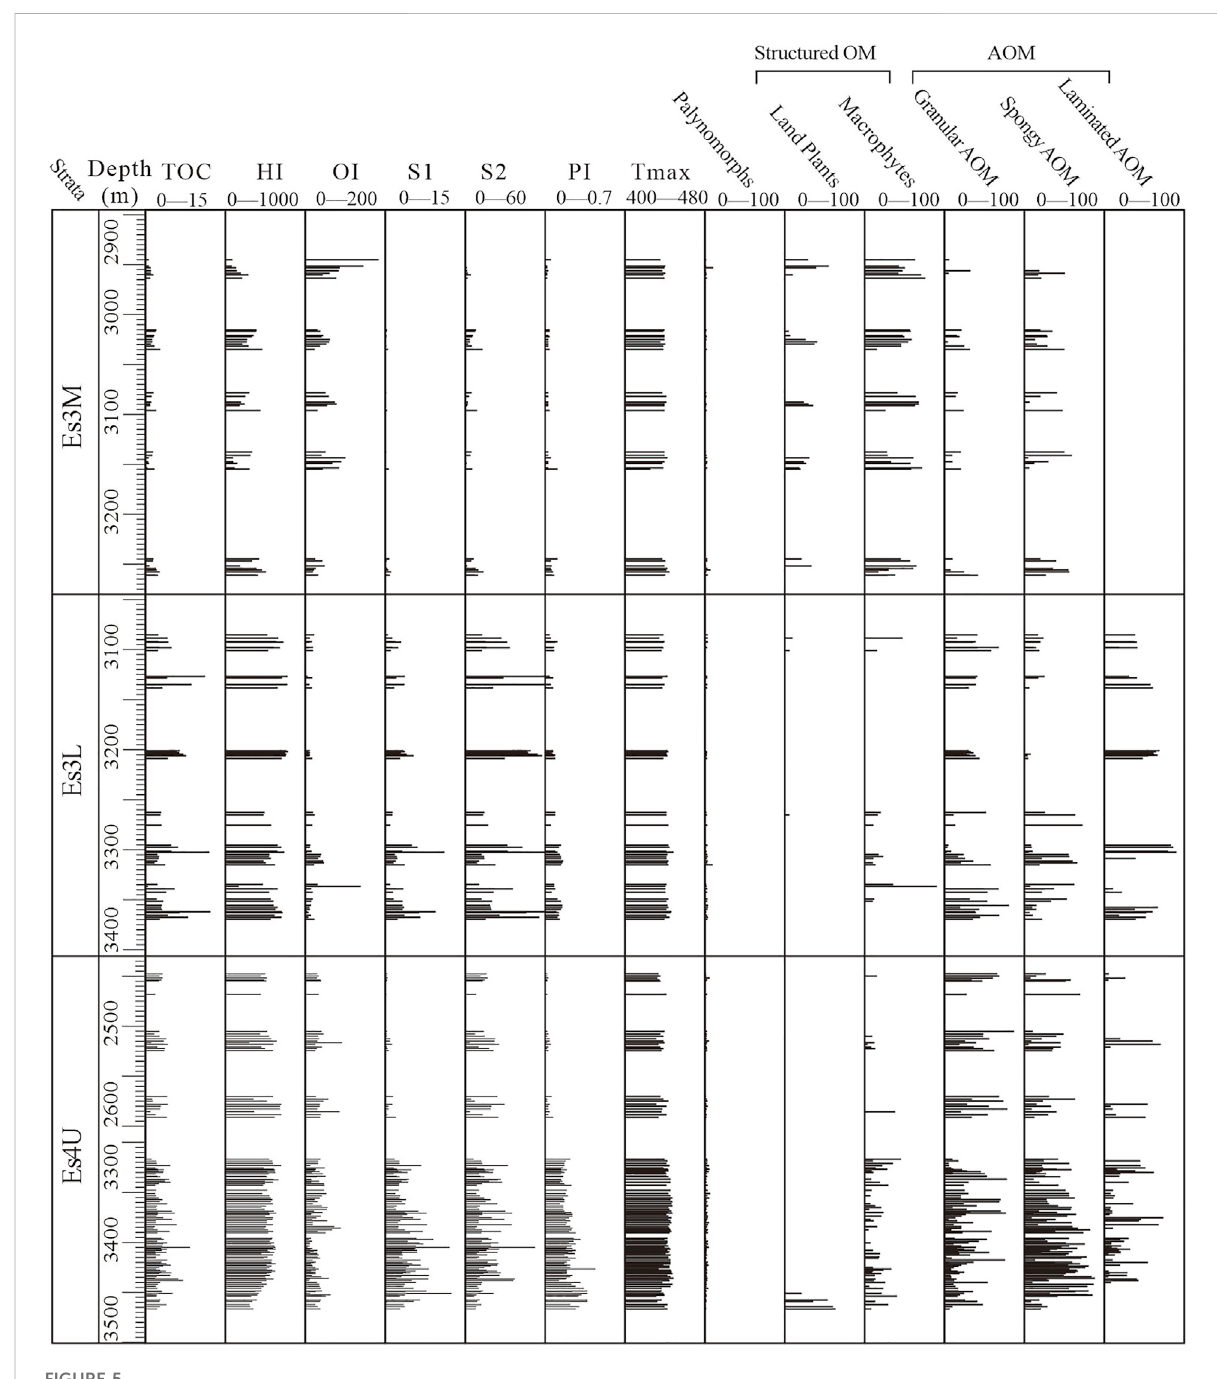
FIGURE 5 Results of pyrolysis and palynofacies